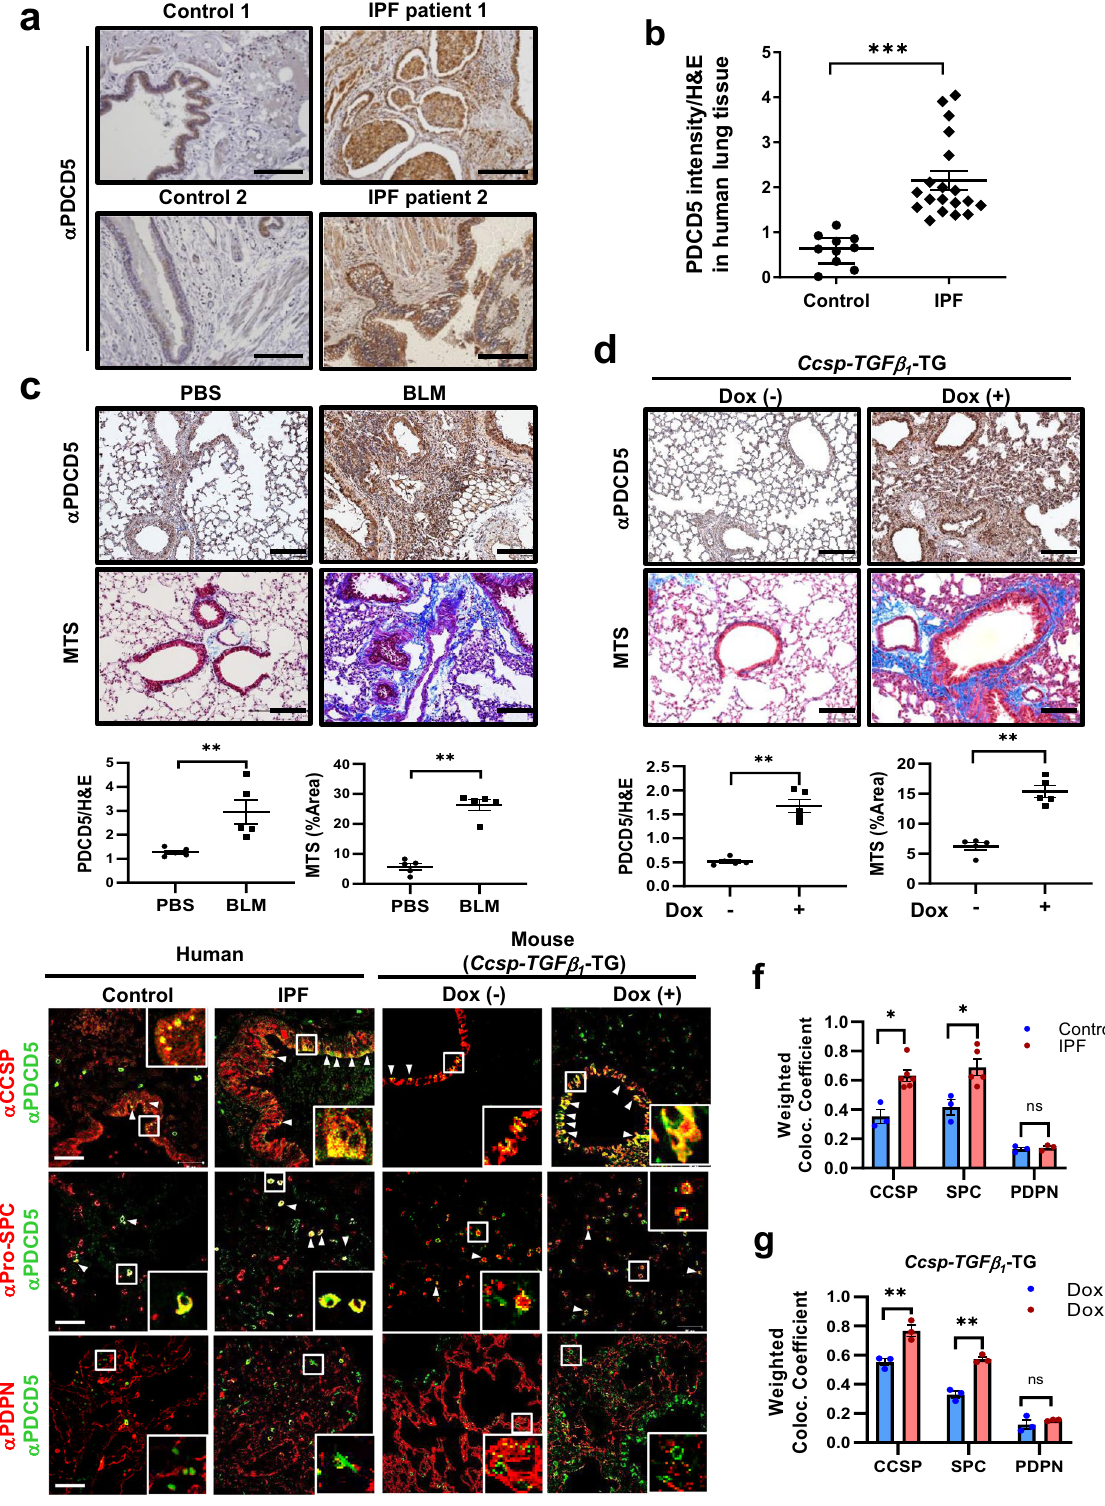
engineered mouse model with tamoxifen-inducible Pdcd5 abla- tion in lung epithelial club cells 14 – 16 ( Ccsp-Pdcd5 d/d ) or AT2 cells 17 ( Spc-Pdcd5 d/d ). First, to verify Cre activity in club cells and AT2 cells after 4-OHT treatment which is a metabolite of the tamoxifen, we adapted a dual fl uorescent membrane-localized tdTomato/eGFP (mTmG) indicator mouse model, which marks Cre -mediated excision via a heritable switch from tdTomato